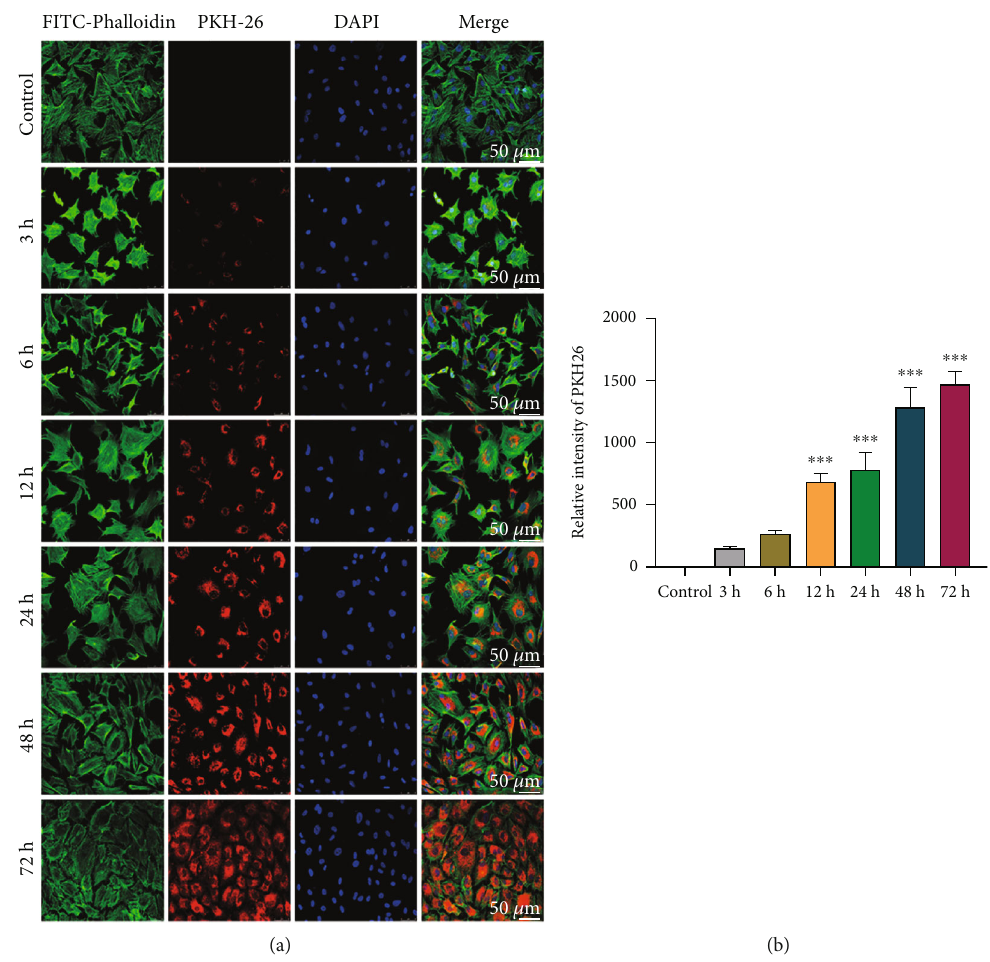
Figure 4: The time course e ff ect of hBMSC-EXO internalization in chondrocytes. (a) EXO internalization was gradually increased along with the time elongation. hBMSC-EXOs were labeled with PKH26 (red) and incubated with primary rabbit chondrocytes at the dosage of 1 × 10 9 /ml . Immuno fl uorescence staining was performed at di ff erent time points as indicated. FITC-Phalloidin (green) and DAPI (blue) were used to label the cytoskeleton and the nucleus, respectively. Scale bar = 50 μ m . (b) The fl uorescence intensity for PKH26. n = 3 . Values are presented as mean ± SEM . ∗∗∗ P < 0 : 001 , versus the control group, one-way